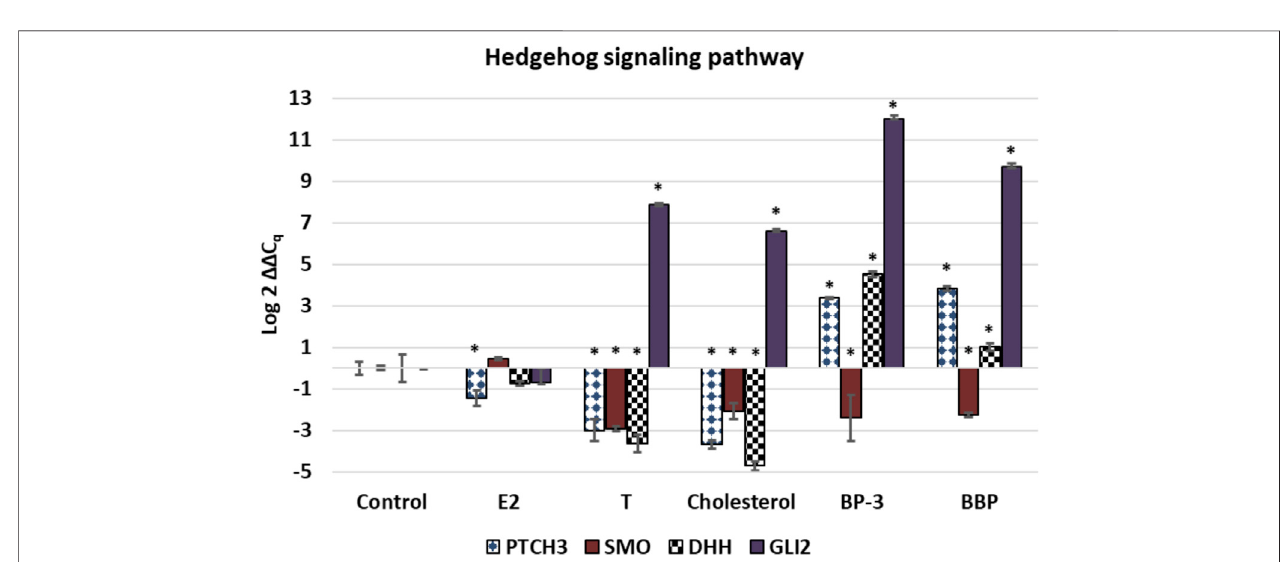
FIGURE 3 | Expression pro fi les of transcripts associated with Hedgehog signaling pathway. The ΔΔ Cq values represent transformed expression of GOI relative to RPL11 expression. An * represents a treatment that was signi fi cantly different ( p < 0.01) relative to the control condition. Error bars represent ± SE. E2: estradiol; T: testosterone;BP-3:oxybenzone;BBP:benzylbutylphthalate.PTCH3:patcheddomain-containingprotein3;SMO:smoothened-like;DHH:DeserthedgehogproteinA; GLI2: zinc fi nger protein GLi2.